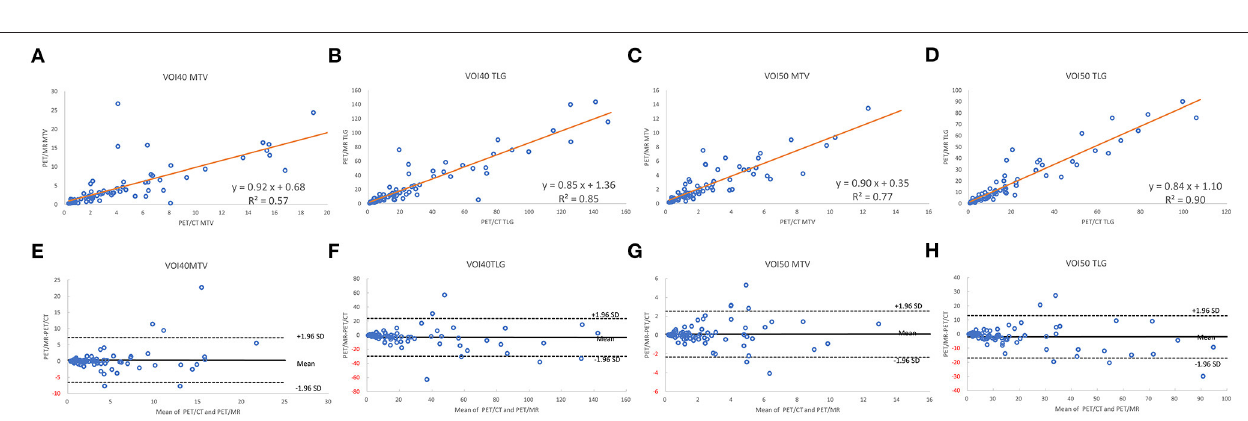
MRAC based on 4-compartment models which consist of air, lung, fat, and soft tissue. Neglecting bone tissues causes an underestimation of SUV uptake more than 10% (13, 43). The